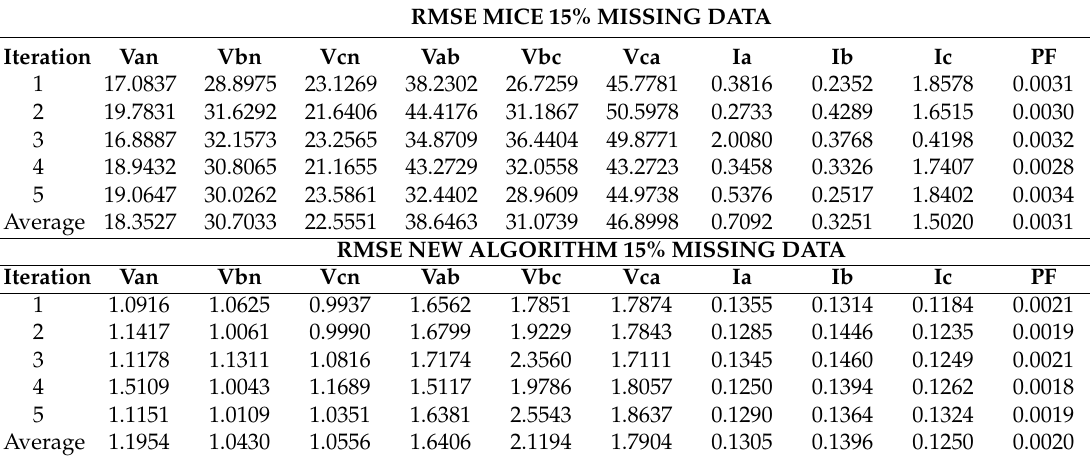
Table 5. RMSE obtained with a 15% of missing data MICE and new proposed AAA